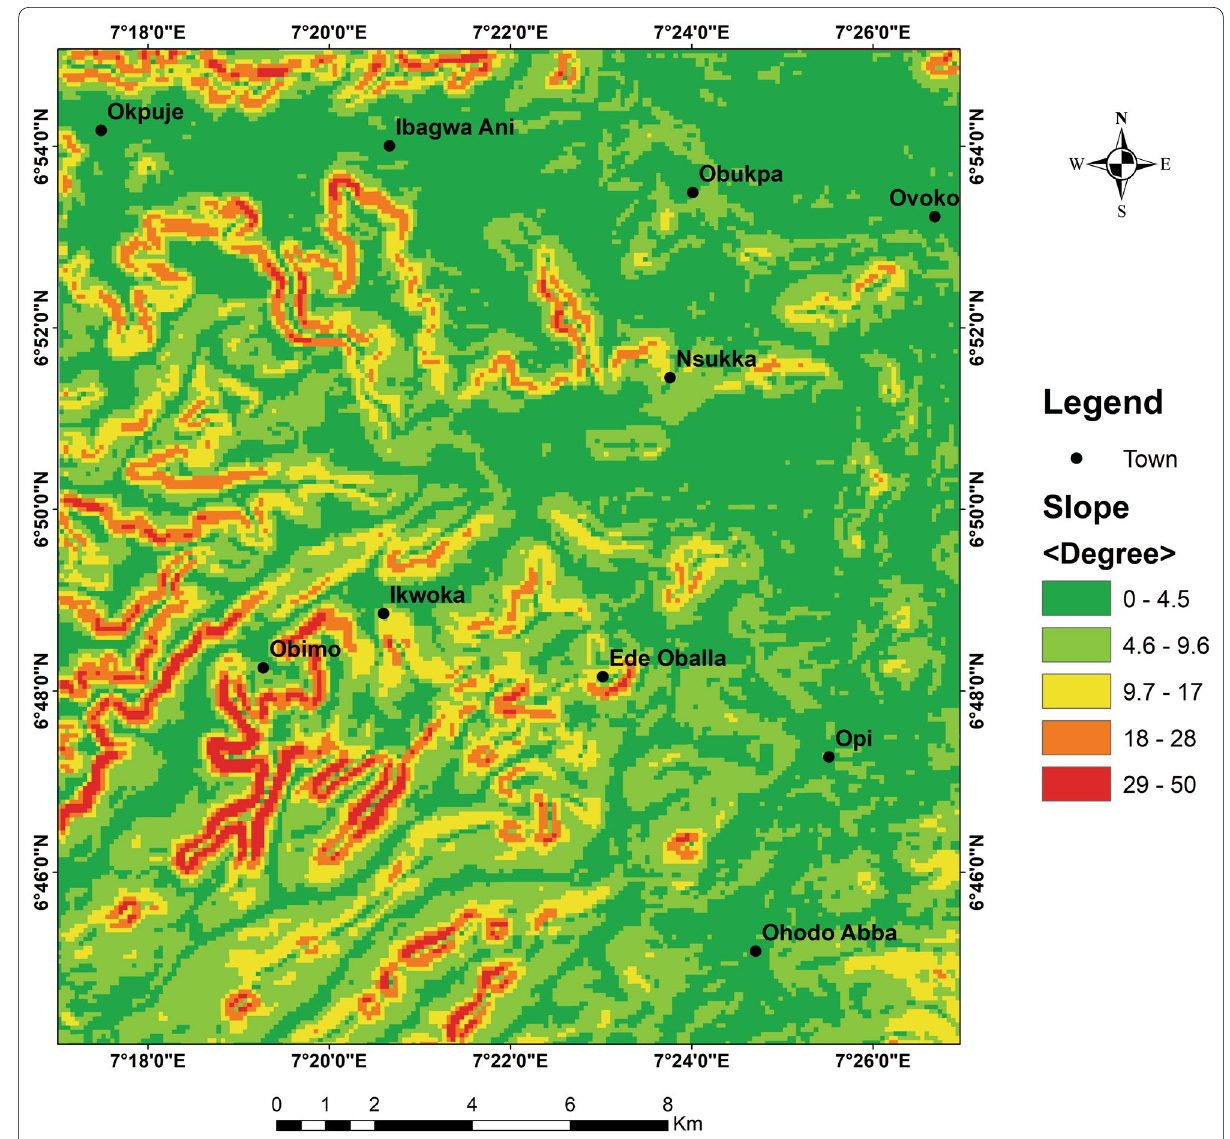
Fig. 5 Slope map (SM) of the study area where Ajali formation outcropped. Generated from NASA SRTM - 30m